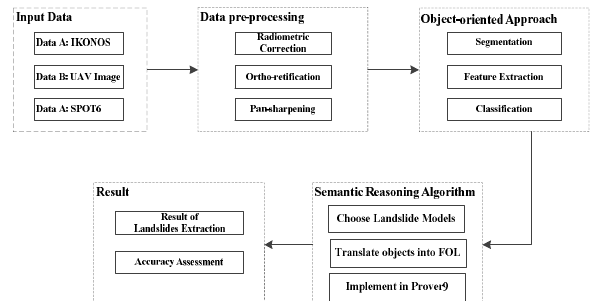
Figure 4. The proposed framework of the landslide extraction based on object-oriented approach and semantic reasoning